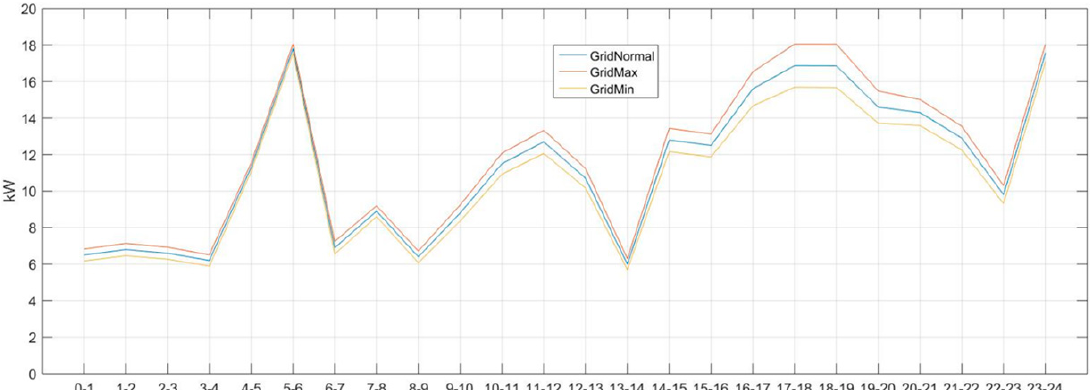
Figure 15. The result of the application of predicted error.